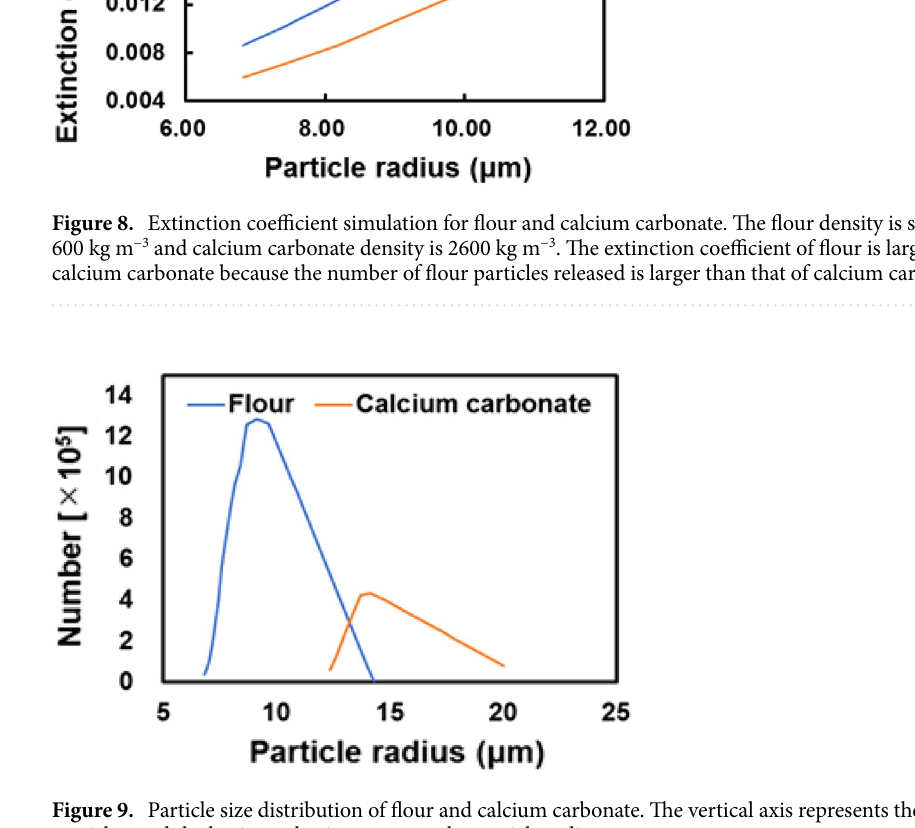
Figure 9. Particle size distribution of flour and calcium carbonate. The vertical axis represents the number of particles, and the horizontal axis represents the particle